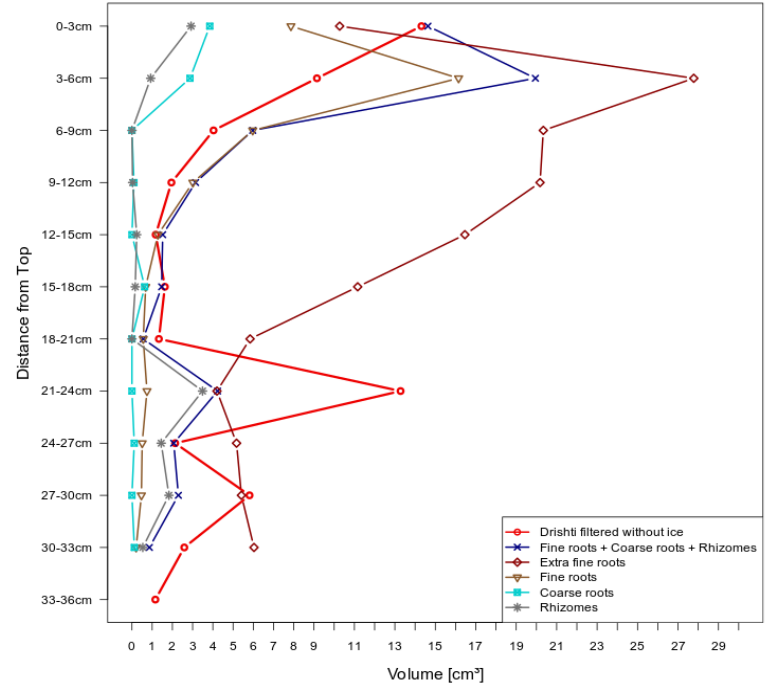
Figure A1. Volume of Drishti volume calculations (RWSS with size filter and ice removed) and